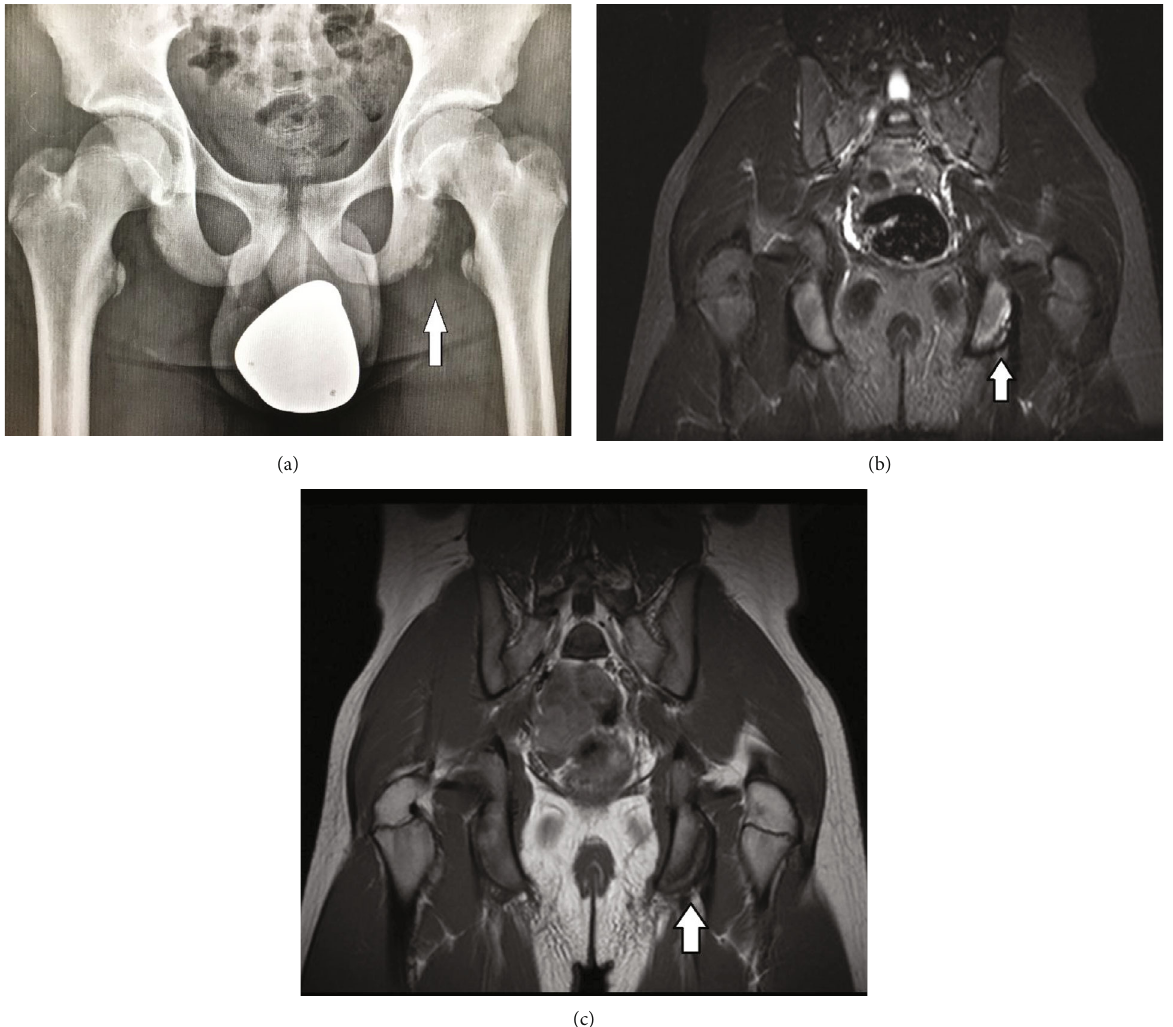
Figure 2: (a) There is an irregular cortex of the left ischial tuberosity, with a smooth line of calci fi cation, in close proximity to the host bone. STIR (b) and T1W (c) sequences in coronal plane of an adolescent with left gluteal pain demonstrate an avulsion lesion of the left ischial tuberosity, with edema of the ischium and minimal displacement of the osteochondral